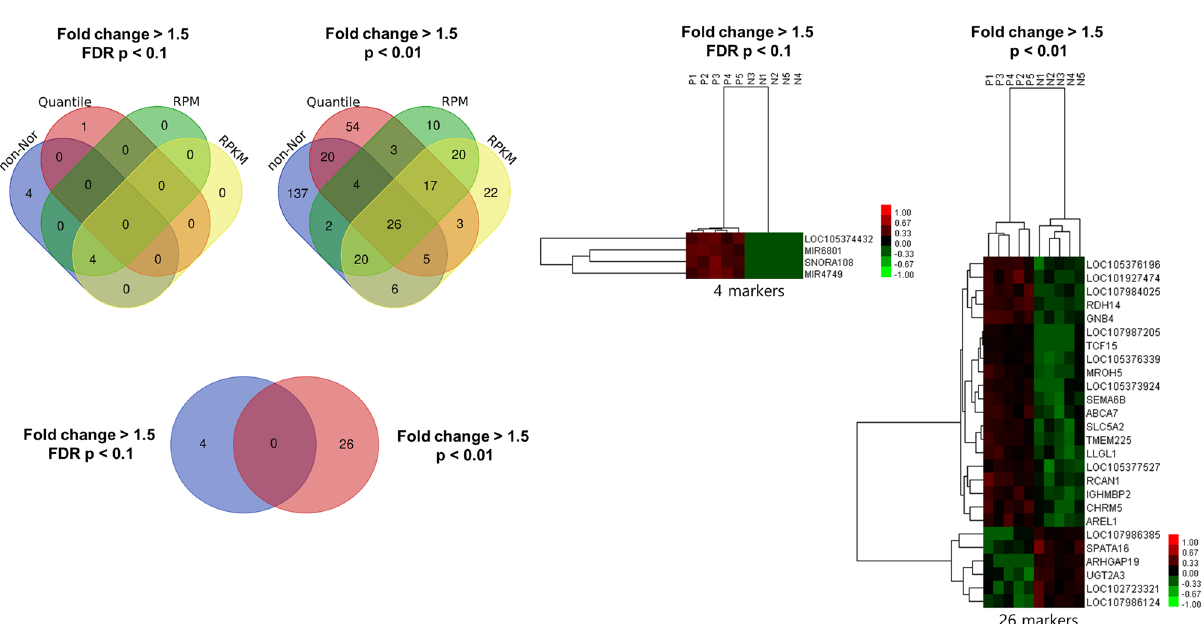
Figure 2. Venn diagram and heat-map comparison of differentially expressed genes from non-normalization, quantile, RPM, RPKM normalization